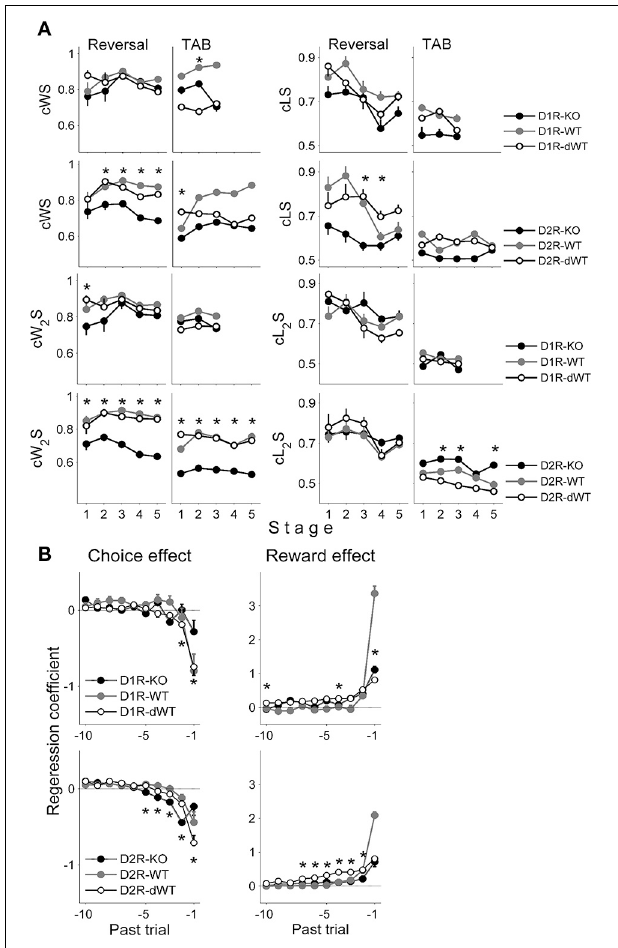
FIGURE 4 | Effects of past choices and rewards on the animal’s choice. (A) Proportions of cWS (repeating rewarded choice in the previous trial), cLS (switching from unrewarded choice in the previous trial), cW 2 S (repeating rewarded choice two trials before) and cL 2 S (switching from unrewarded choice two trials before) are shown for each behavioral stage. Asterisks, significant difference between KO and dWT mice (Two-Way repeated measure ANOVA followed by Bonferroni post-hoc tests, p < 0.05). (B) Results of a logistic regression analysis. Effects of past choices and rewards (up to 10 trials) on the animal’s choice in the current trial were estimated by applying a logistic regression analysis to the behavioral data obtained during the TAB task (D1R, stages 1–3; D2R, stages 1–5). A positive coefficient for the choice effect indicates the animal’s tendency to repeat the same choice, and a positive coefficient for the reward effect indicates the animal’s tendency to repeat the rewarded choice. Error bars, 95% confidence intervals. Asterisks, significant difference between KO and dWT mice (One-Way ANOVA followed by Bonferroni post-hoc tests, p < 0.05).